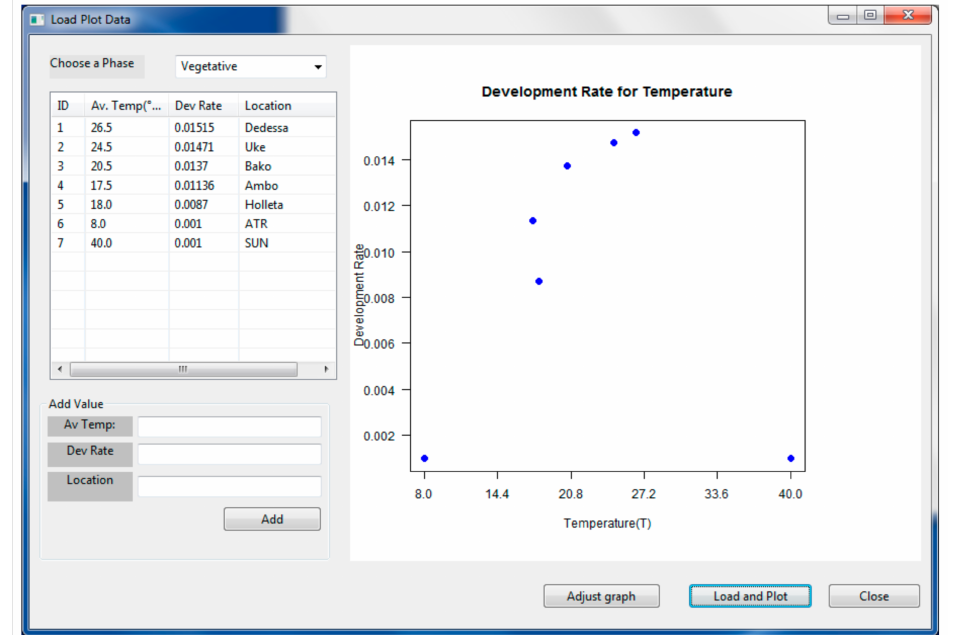
Figure 4. PPMaP data file display window. It contains the compilation of data of the vegetative phase of a maize variety. The columns on the left box contain, the ID, average temperature, numerical values of the development rate, and the locations. The right box shows in two dimensions the data recorded in the left box.